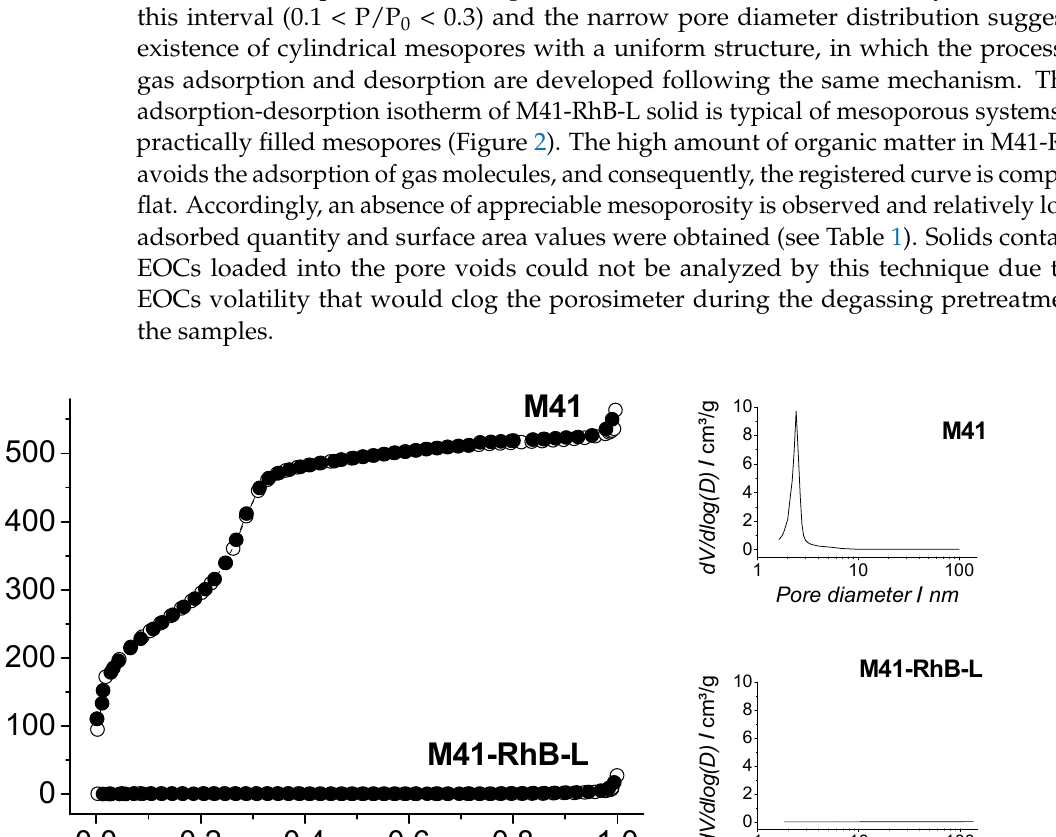
Figure 1. ( A ) Normalized powder X-ray patterns of all the synthesized solids. From bottom to top, the reported solids are M41-Thy-L ( c ), M41-Eug-L ( d ) and M41-Cin-L ( e ). ( B ) TEM micrographs of starting bare material M41 ( a ), and loaded and functionalized solids M41-RhB-L ( b ), M41-Thy-L ( c ), M41-Eug-L ( d ) and M41-Cin-L ( e ), and particle size estimation ( f ). Insets correspond to a 2x magnification of the selected areas.